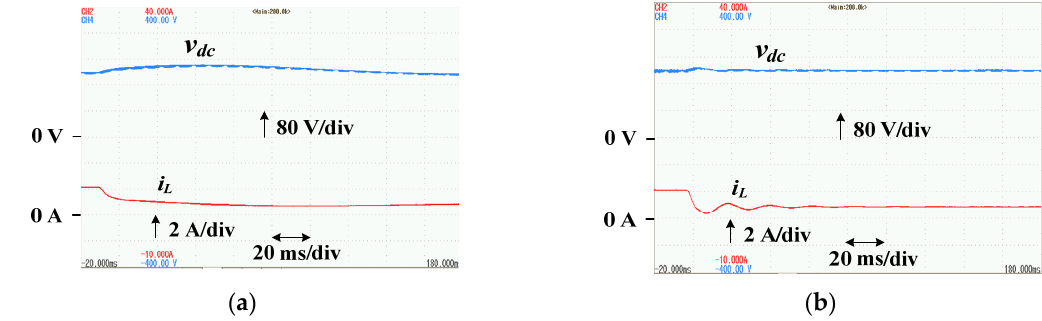
Figure 19. Load variation (500 W to 200 W). ( a ) PI control; ( b ) LQR.